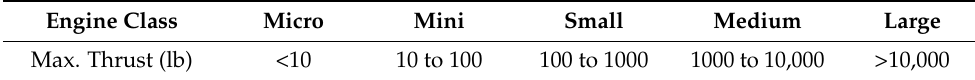
Table 1. Maximum thrust of various engine classes. Engine